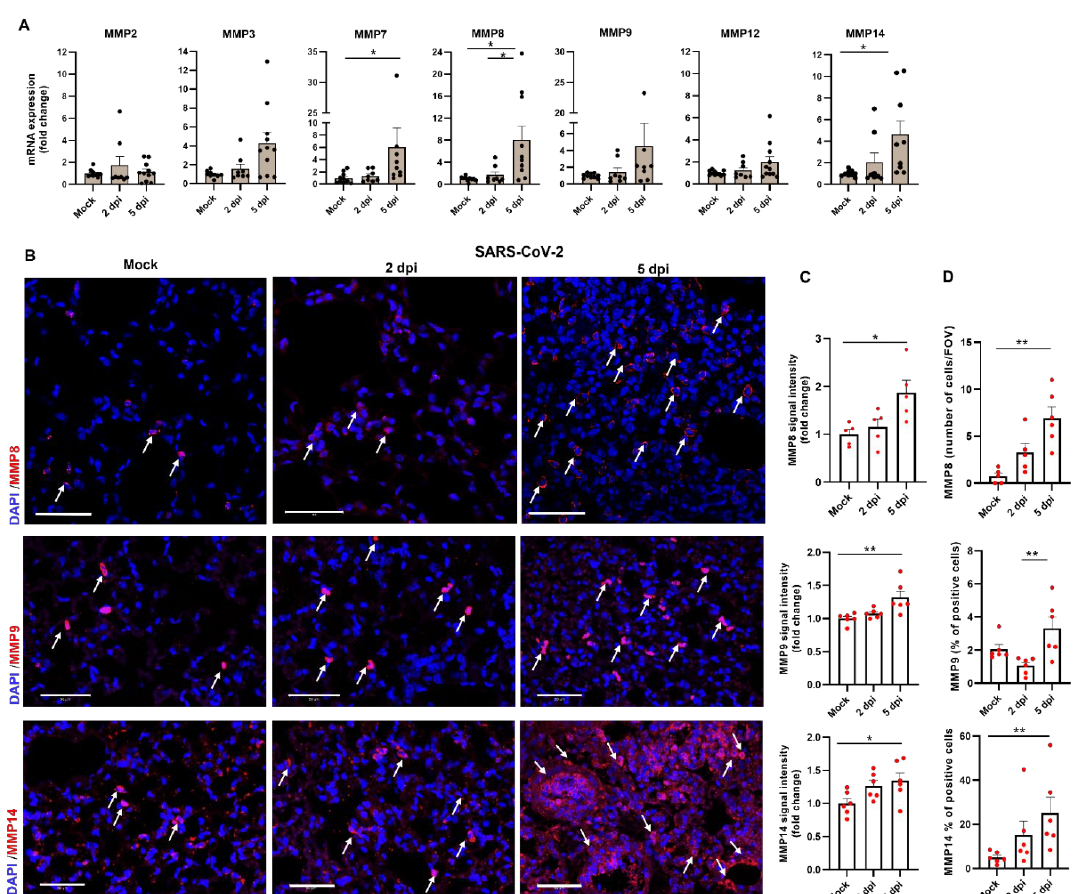
Figure 3. Increased MMPs expression in the lungs of K18-hACE2 mice following SARS-CoV-2 infection. ( A ) Quantitative RT-PCR analysis of MMP mRNA in the lungs of K18-hACE2 mice 2 and 5 dpi compared to mock. Data presented as mean ± SEM (n = 8–11 mice per time point). ( B ) Representative immunofluorescence images of lung sections labeled for MMP8 (upper panel), MMP9 (middle panel) and MMP14 (lower panel) at 2 and 5 days post SARS-CoV-2 infection compared to mock Scale bar: 50 µ m. Arrowheads indicate MMPs labeled cells. ( C ) Mean fluorescence signal intensity of MMP8, MMP9, and MMP14 and ( D ) number of cells for MMP8 and percent of positive cells for MMP9 and MMP14 in lung sections of mock and SARS-CoV-2-infected mice at 2 and 5 dpi (n = 5–6 mice for mock and n = 5–6 for 2 dpi and n = 5–6 for 5 dpi. For MMP8 analysis, 5 fields were imaged for each mouse for MMP9 and MMP14 analysis 25 fields were imaged for each mouse. Statistical significance was calculated using Kruskal–Wallis nonparametric test * p < 0.05, ** p <